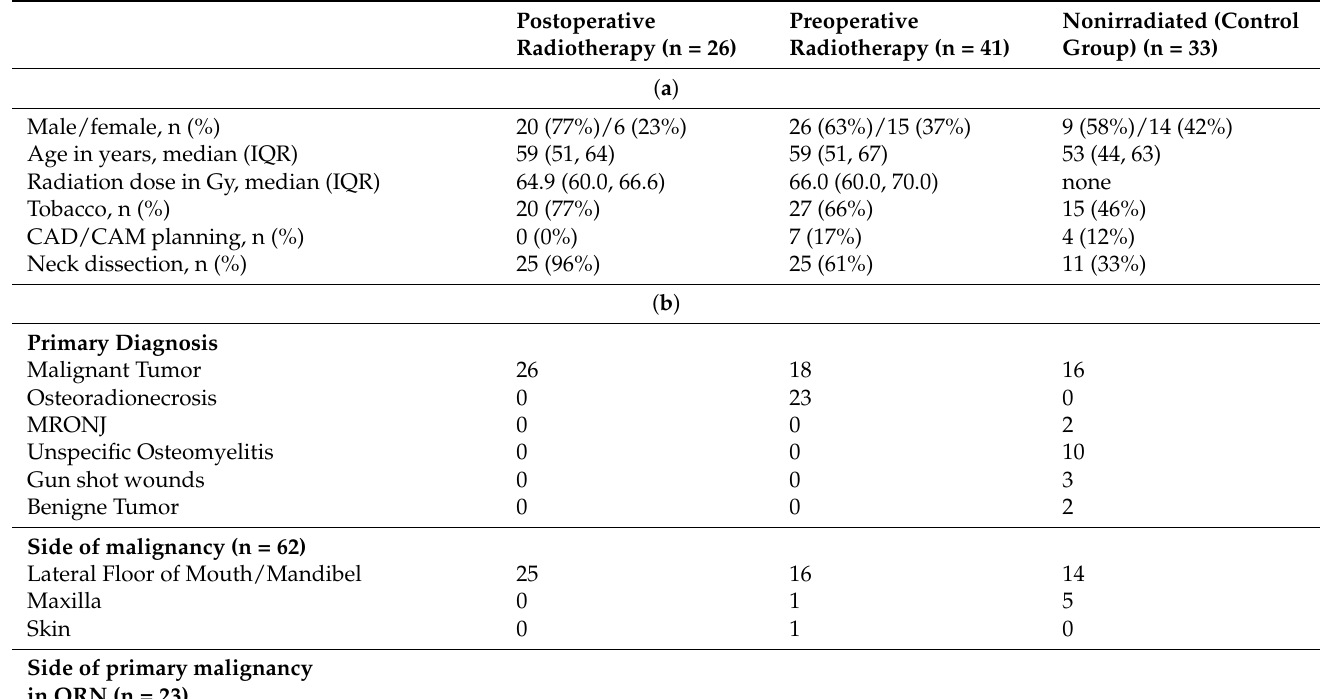
Table 1. Cohort characteristics. ( a ) General information of all three groups. ( b ) Primary diagnosis and location for all three groups. ( c ) Defect classification and types of microvascular flap